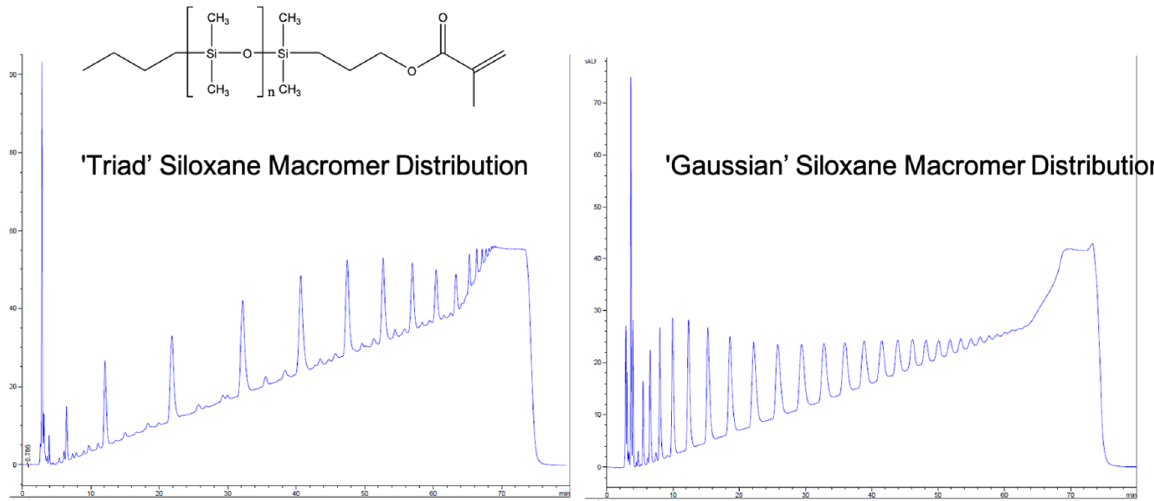
Figure 2. Comparison of silicone macromers demonstrating polymer termini scrambling (GC of methacrylate functional macromer (MCR-M11) with a nominal MW of 1000 showing shift from Triad to Gaussian distribution with a change in promoter. (Author’s work)).